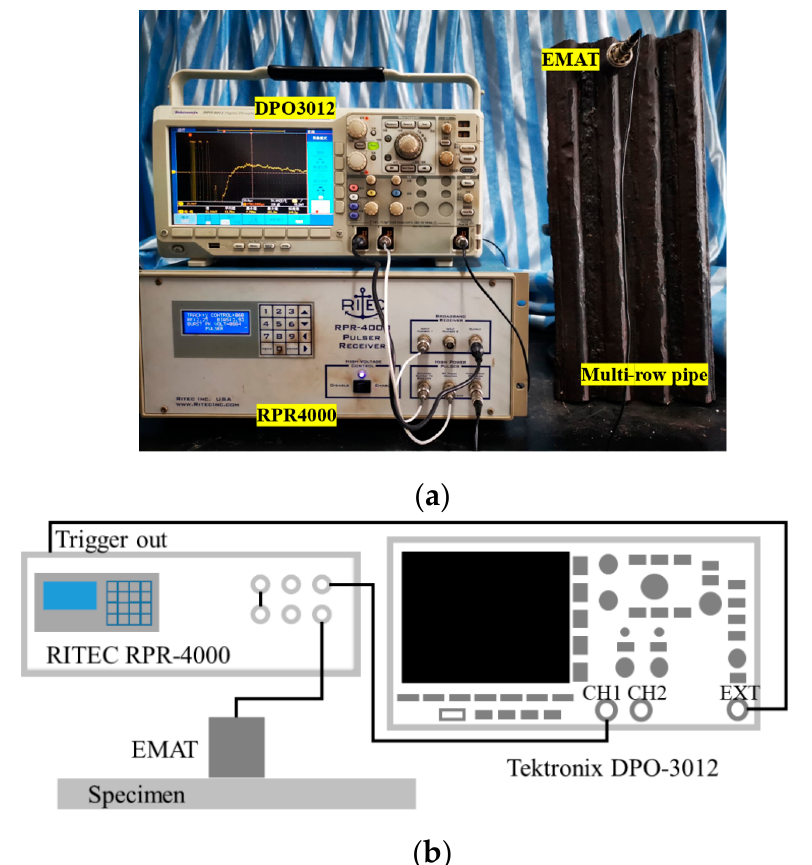
Figure 2. ( a ) Photo of experimental setup; ( b ) Schematic diagram of EMAT testing system. Table 1. Specimen parameters (unit: mm).